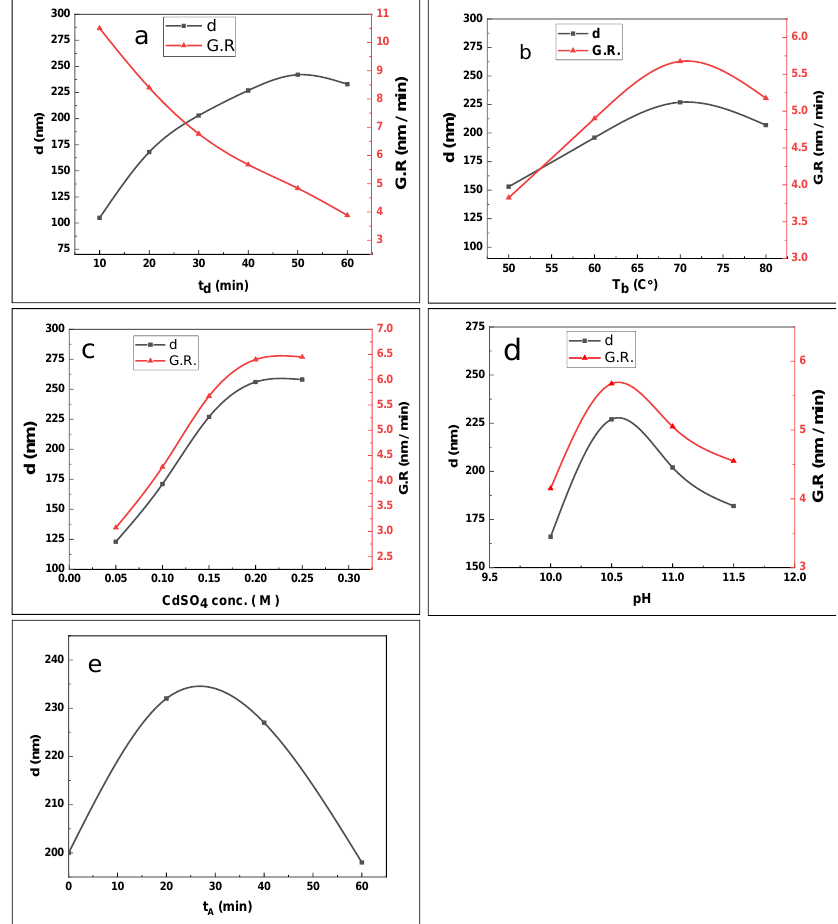
Figure 4. The variation of thickness and growth rate of CdO thin films with ( a ) deposition time, ( b ) bath temperature, ( c ) CdSO 4 concentration, ( d ) pH of the bath, and ( e ) annealing time.